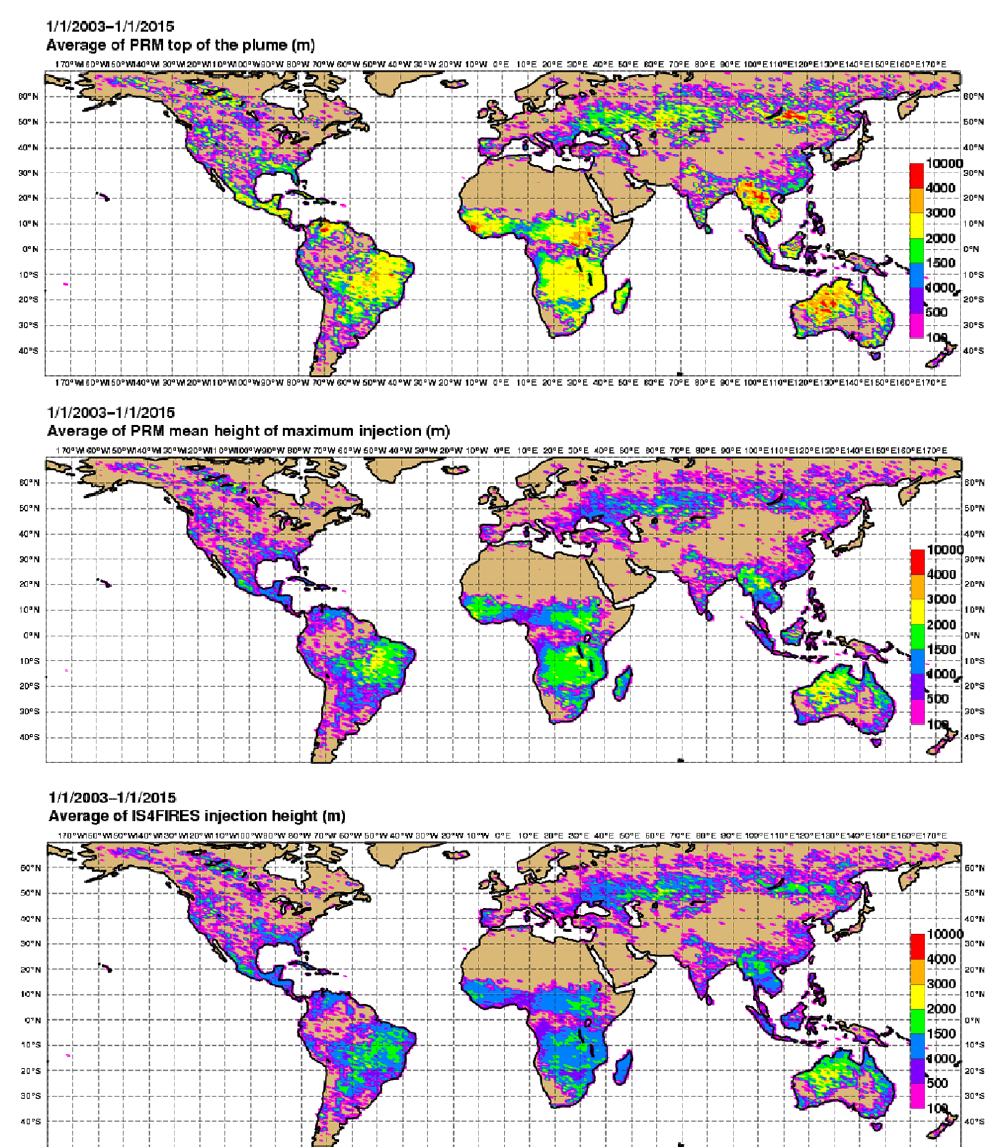
Figure 4. Global average for the 1 January 2003–1 January 2015 period of daily injection heights from GFAS. Top of the plume (top), mean height of maximum injection (middle) from the PRM and injection height estimated with the IS4FIRES parameterisation (bottom). The averages were computed taking into account only non-null